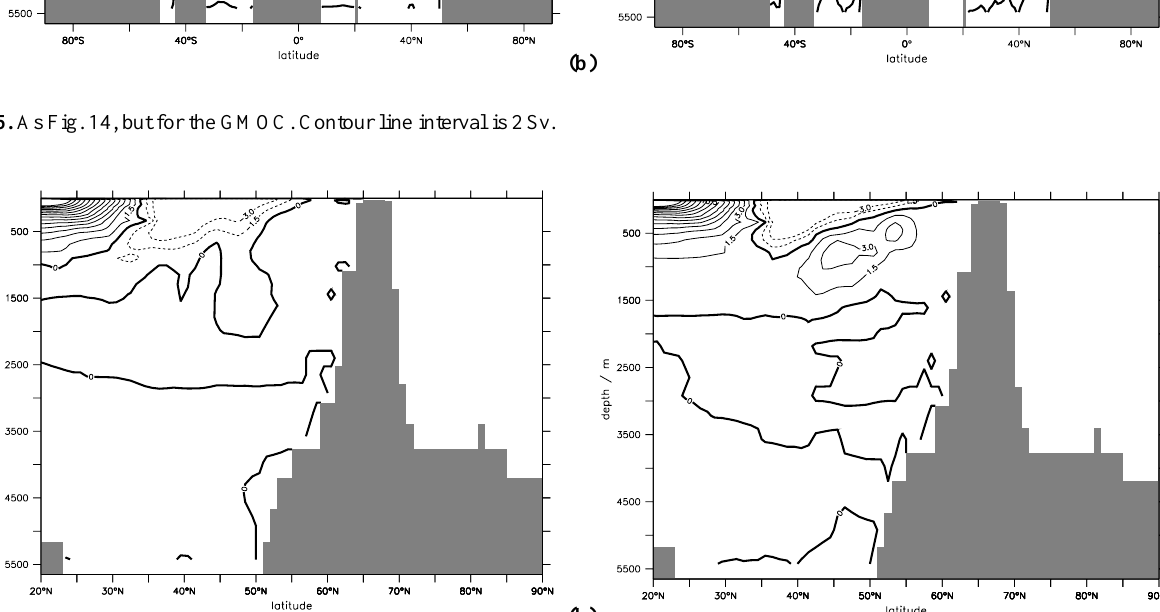
Fig. 16. As Fig. 14, but for the PMOC. Contour line interval is